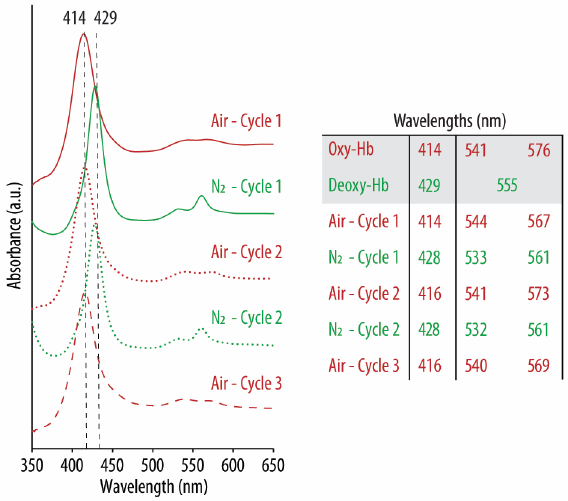
Figure 6. UV-vis spectra of oxygenated (oxy-Hb) and deoxygenated (deoxy-Hb) Hb after successively purging with compressed air (red lines) and nitrogen (N 2 ) gas (green lines) the optimized HbNPs (i.e., HbNPs-26). The HbNPs were fabricated using 75 mg mL − 1 Hb, 3 mg mL − 1 PLGA, and 0.5%